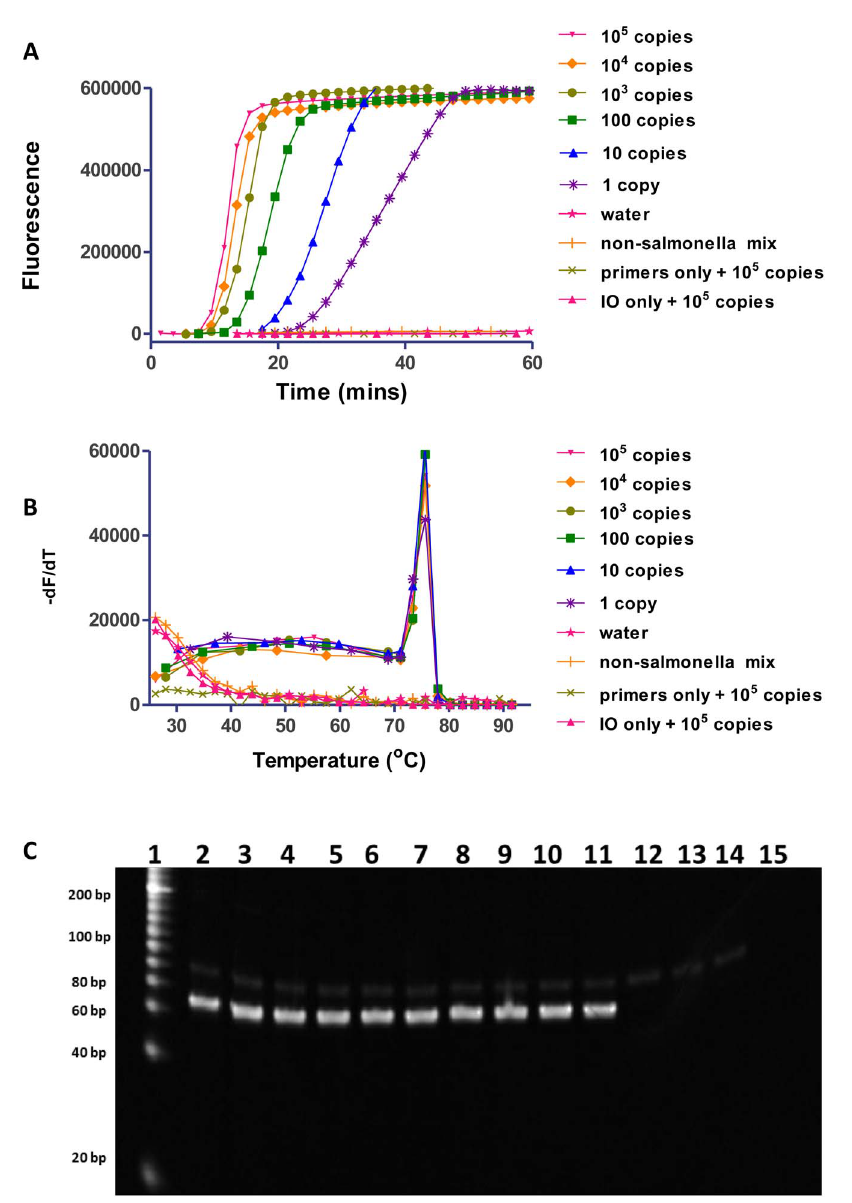
Figure 5. Determination of SIBA sensitivity for Salmonella genomic DNA. (A) Real-time monitoring of DNA amplification using SYBR Green I, (B) melting curve analysis, ((-dF (fluorescence)/dT (temperature) versus temperature) and (C) electrophoresis of the corresponding reaction products. Lane 1, BioRad EZ Load 20 bp Molecular Ruler (20–1000 bp); lanes 2–11 primers + IO + 10 5 , 10 4 , 10 3 , 100, 50, 20, 10, 5, 2, or 1 copy of Salmonella genomic DNA, respectively; lane 12, primers + IO + water; lane 13, primers + IO + a mixture of non- Salmonella spp. genomic DNA (each spp. contains 1000 copies per reaction); lane 14, IO + 10 5 copies Salmonella genomic DNA; lane 15, primers + 10 5 copies Salmonella genomic DNA; 50, 20, 5 and 2 copies were omitted from Figure 5a and b for the sake of clarity. SM-F18 and SM-R16 were the forward and reverse primers, respectively. The IO used was